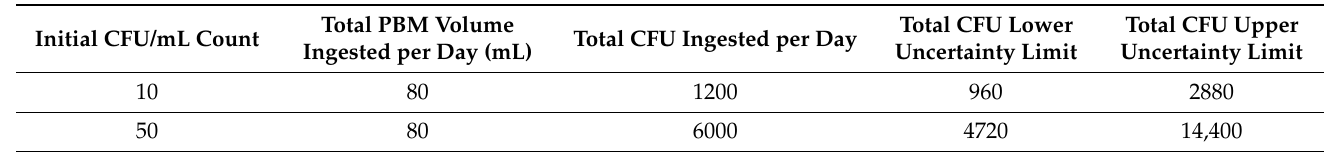
Table 8. The predicted number of B. cereus CFU ingested per day for initial post-pasteurization concentrations of 10 and 50